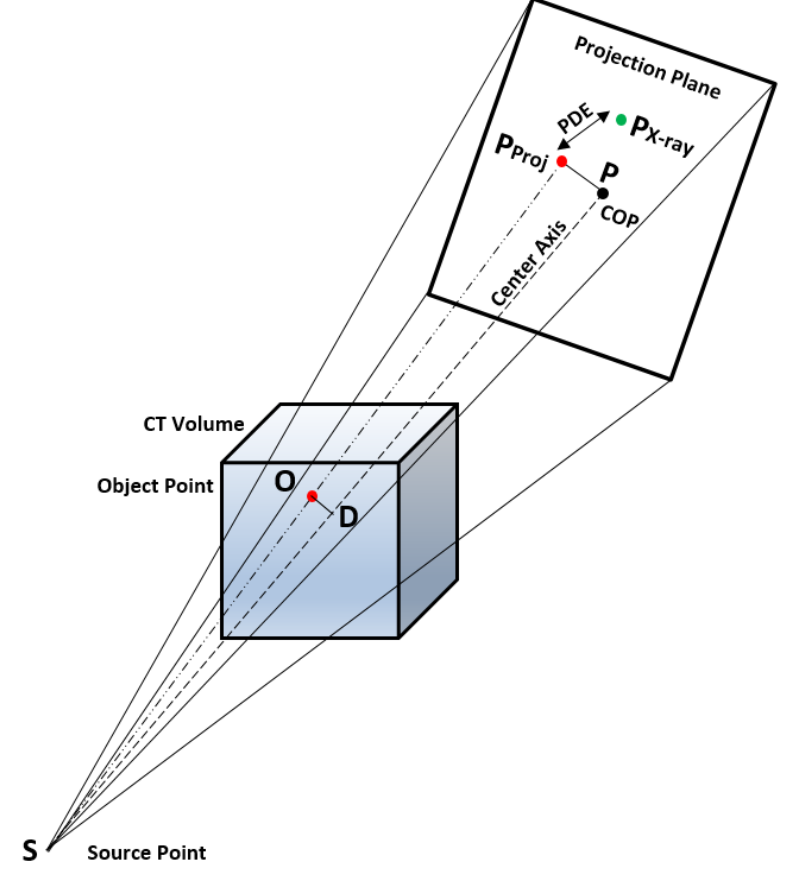
Figure 3. Depiction of C-arm camera model to project 3D point on 2D projection plane and PDE